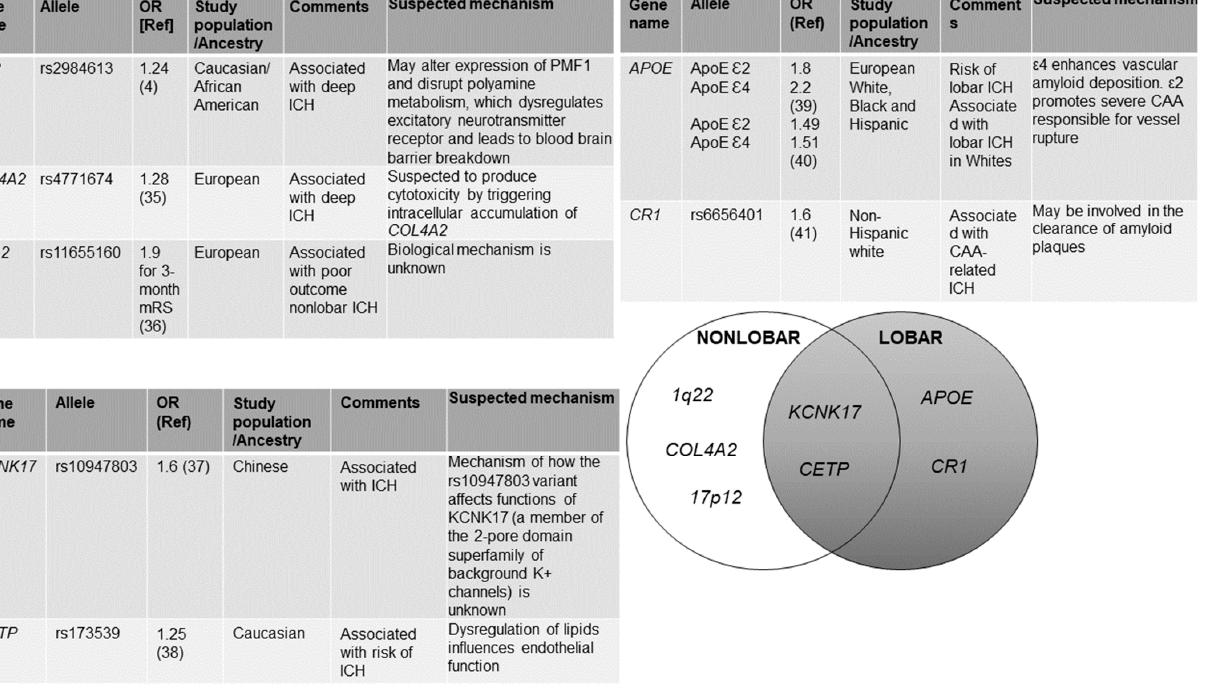
Figure 1. Genetic variants associated with primary intracerebral hemorrhage from genome